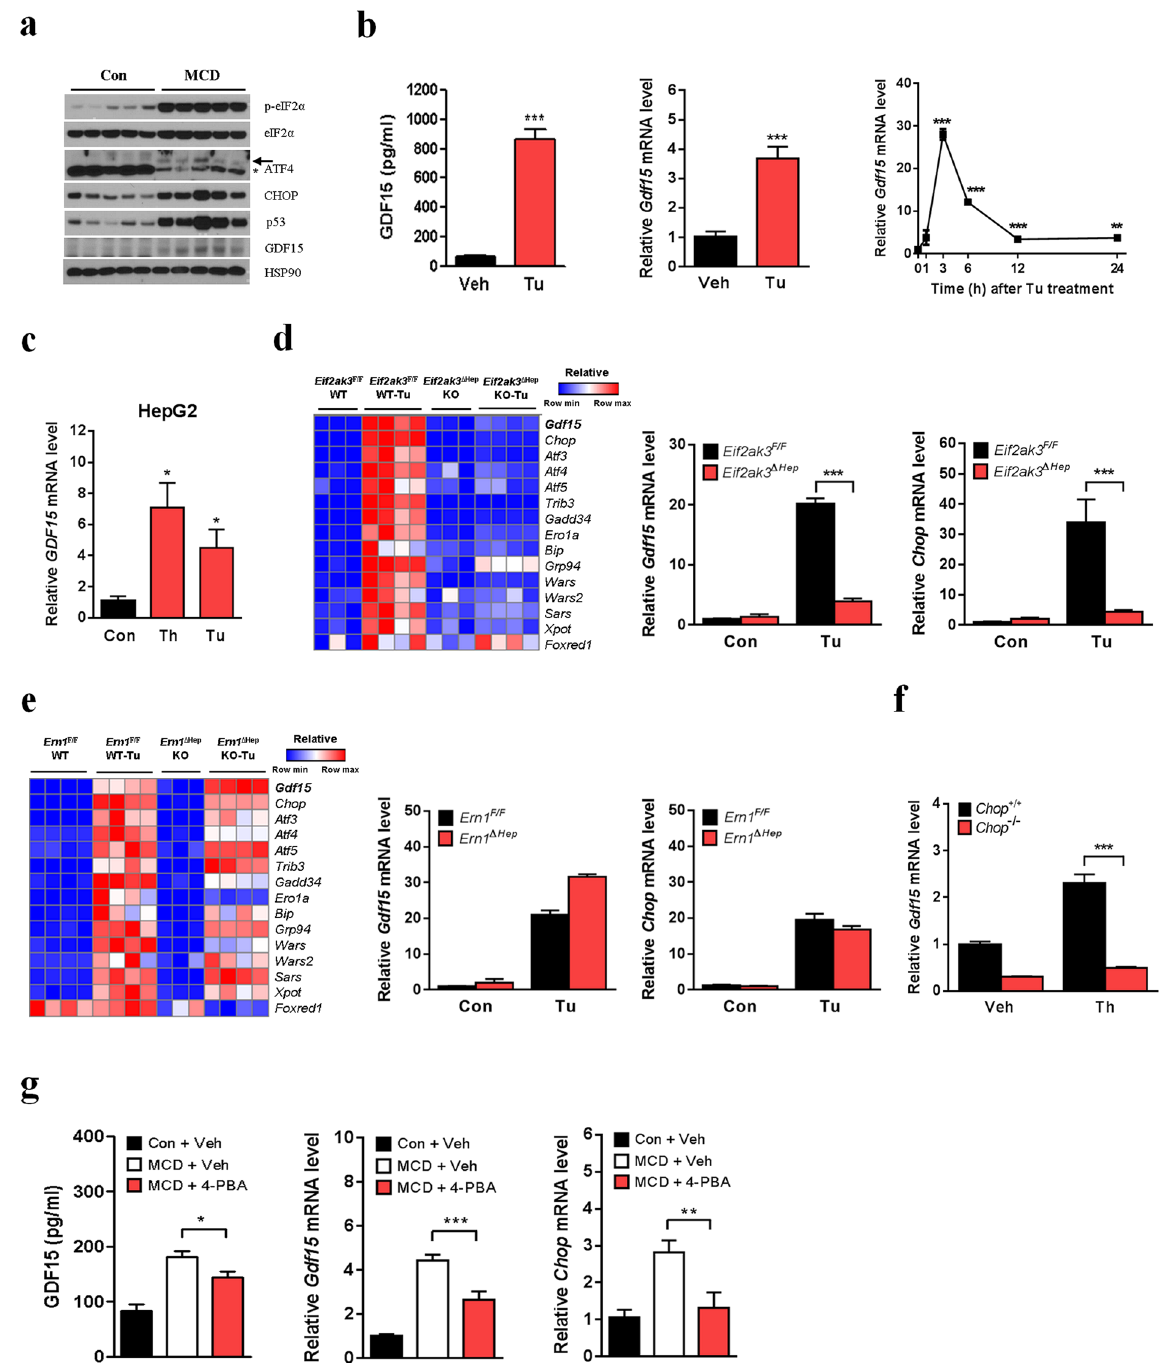
Figure 2. ER stress mediates MCD diet-induced GDF15 expression. ( a ) Immunoblot analysis of liver lysates from C57BL/6 mice fed MCD diet for 8 weeks. Asterisk indicates a non-specific band. ( b ) Serum GDF15 (left panel, n = 6) and relative hepatic Gdf15 mRNA levels (middle panel, n = 4) in C57BL/6 mice 24 h after tunicamycin (Tu, 1 mg/kg) or vehicle (Veh) injection. Time-course of the changes in mouse liver Gdf15 mRNA level after Tu injection (right panel, n = 3). ( c ) Relative GDF15 mRNA level in HepG2 cells after incubation with Tu (5 μ g/ml) or thapsigargin (Th, 1 μ M) for 24 h (n = 3). ( d , e ) A heatmap showing relative expression of Gdf15 and upstream or downstream genes of CHOP, and Gdf15/Chop mRNA levels in the livers of Eif2ak3 Δ hep mice ( d , GSE29929) and Ern1 Δ hep mice ( e , GSE40515). ( f ) Relative Gdf15 mRNA level in Chop –/– MEFs treated with Th (1 μ M) (n = 3). ( g ) Serum GDF15 (n = 8–9) and relative hepatic Gdf15 or Chop mRNA levels (n = 5) in MCD diet-fed C57BL/6 mice treated with 4-PBA (1 g/kg/day) or vehicle (Veh) for 9 days. Data are means ± SEM. * p < 0.05, ** p < 0.01, *** p <